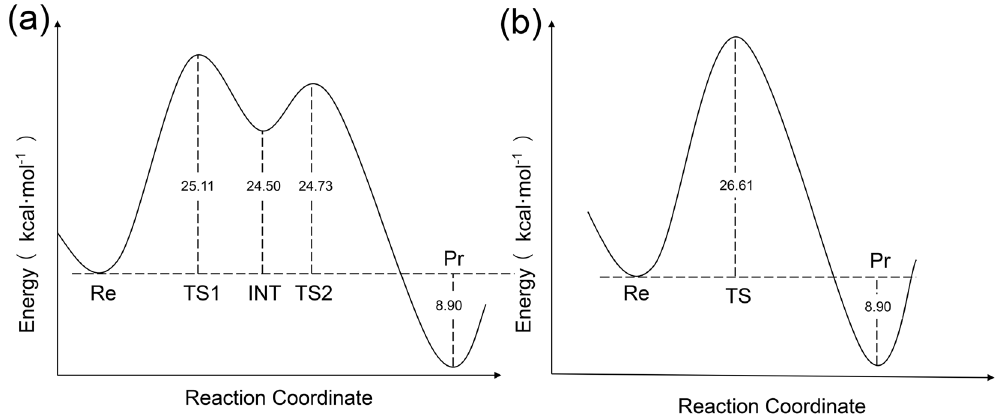
Figure 5. Calculated energy profile along the reaction coordinates in two YhdE hydrolysis pathways. ( a ) Stepwise pathway. The energy barrier of this pathway is 25.11 kcal mol − 1 . ( b ) Concerted pathway. The energy barrier of this pathway is 26.61 kcal mol − 1 .